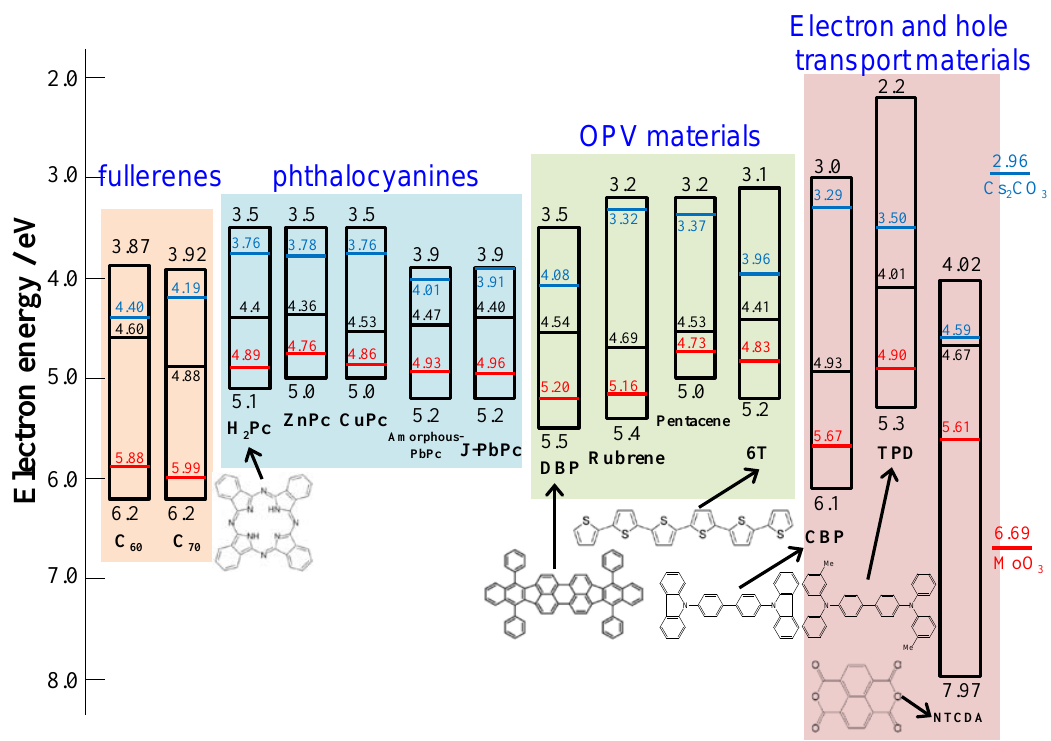
Figure 12. Energy diagrams of various organic semiconductor films. The black, red, and blue lines show the energetic position of E films. The doping concentration is 3000 ppm. E are also